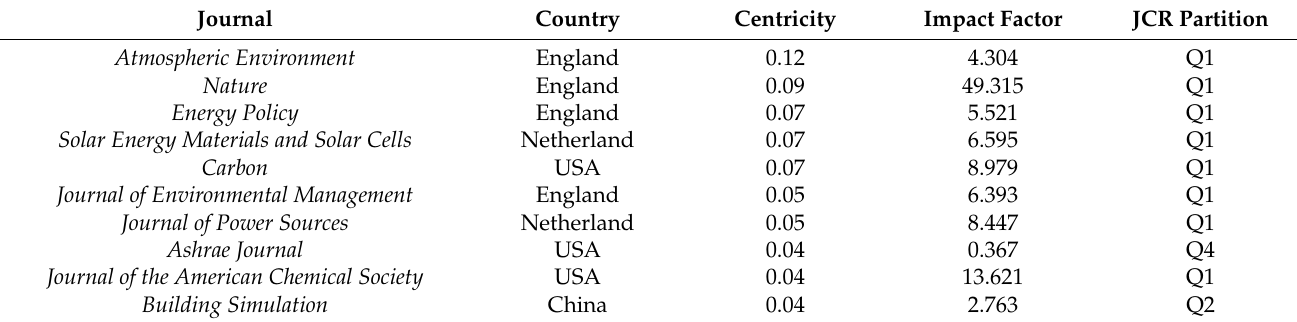
Table 9. Journals cited for high centricity and related information.